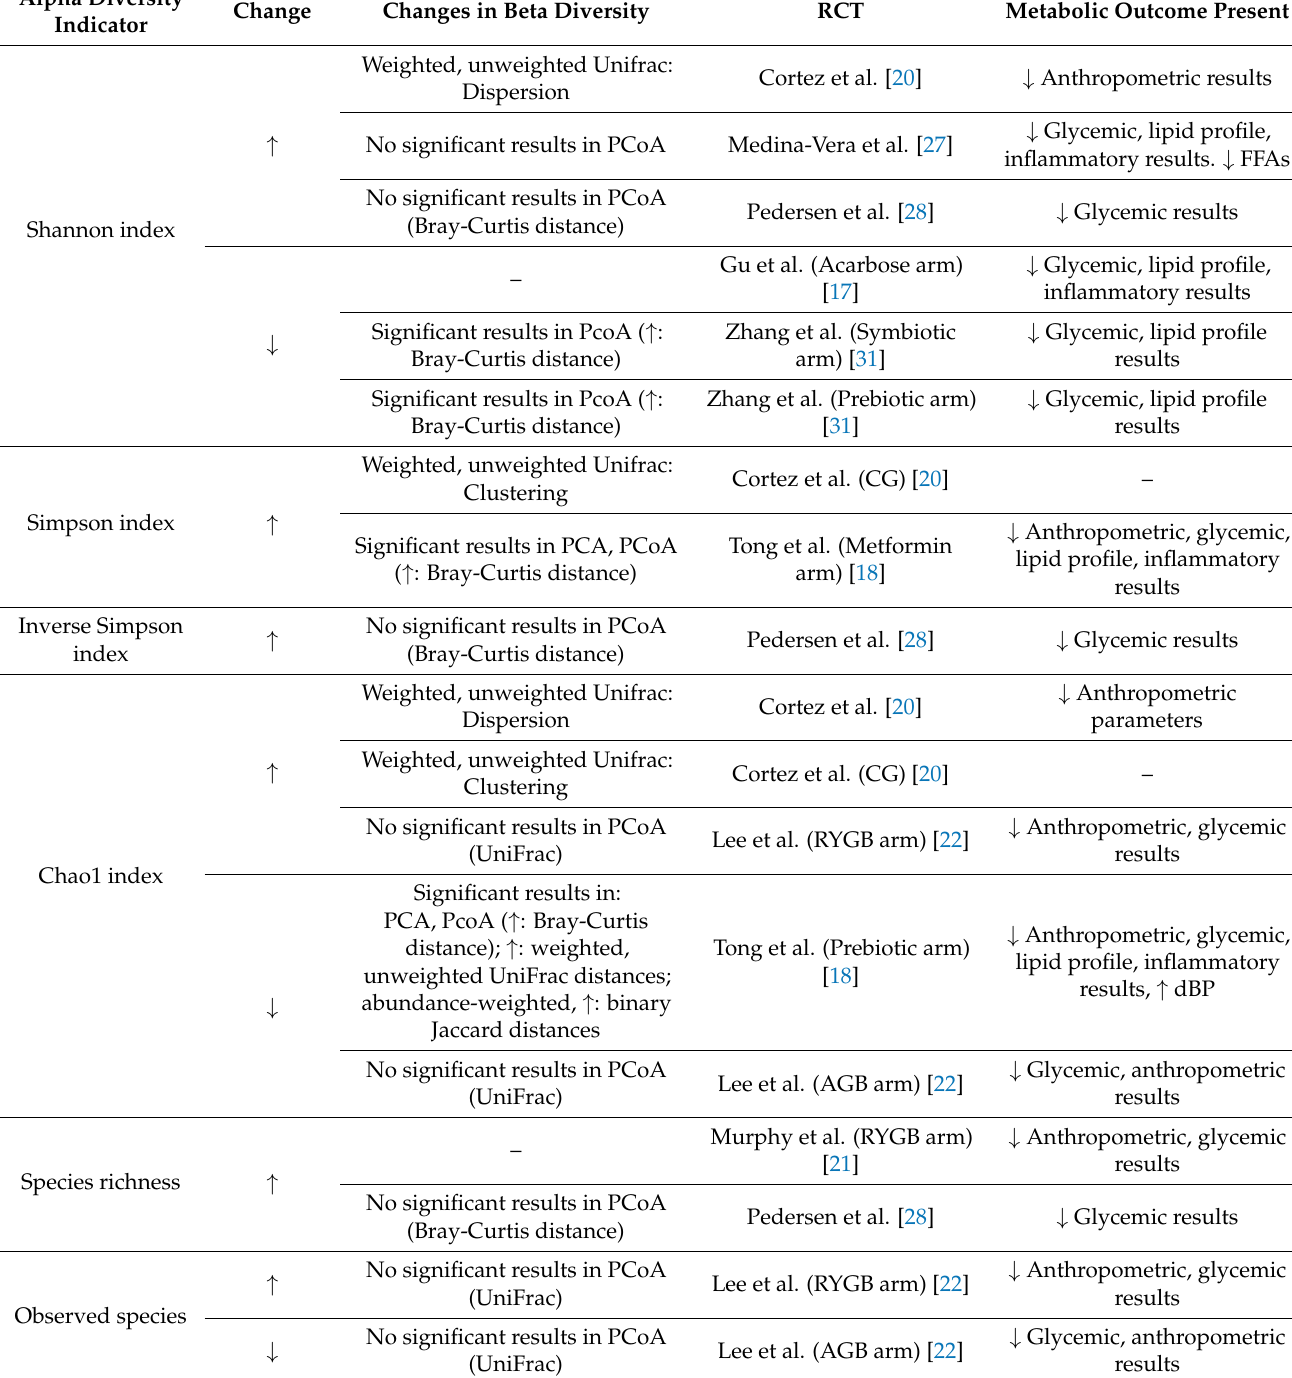
Table 3. Alpha and beta diversity changes in included